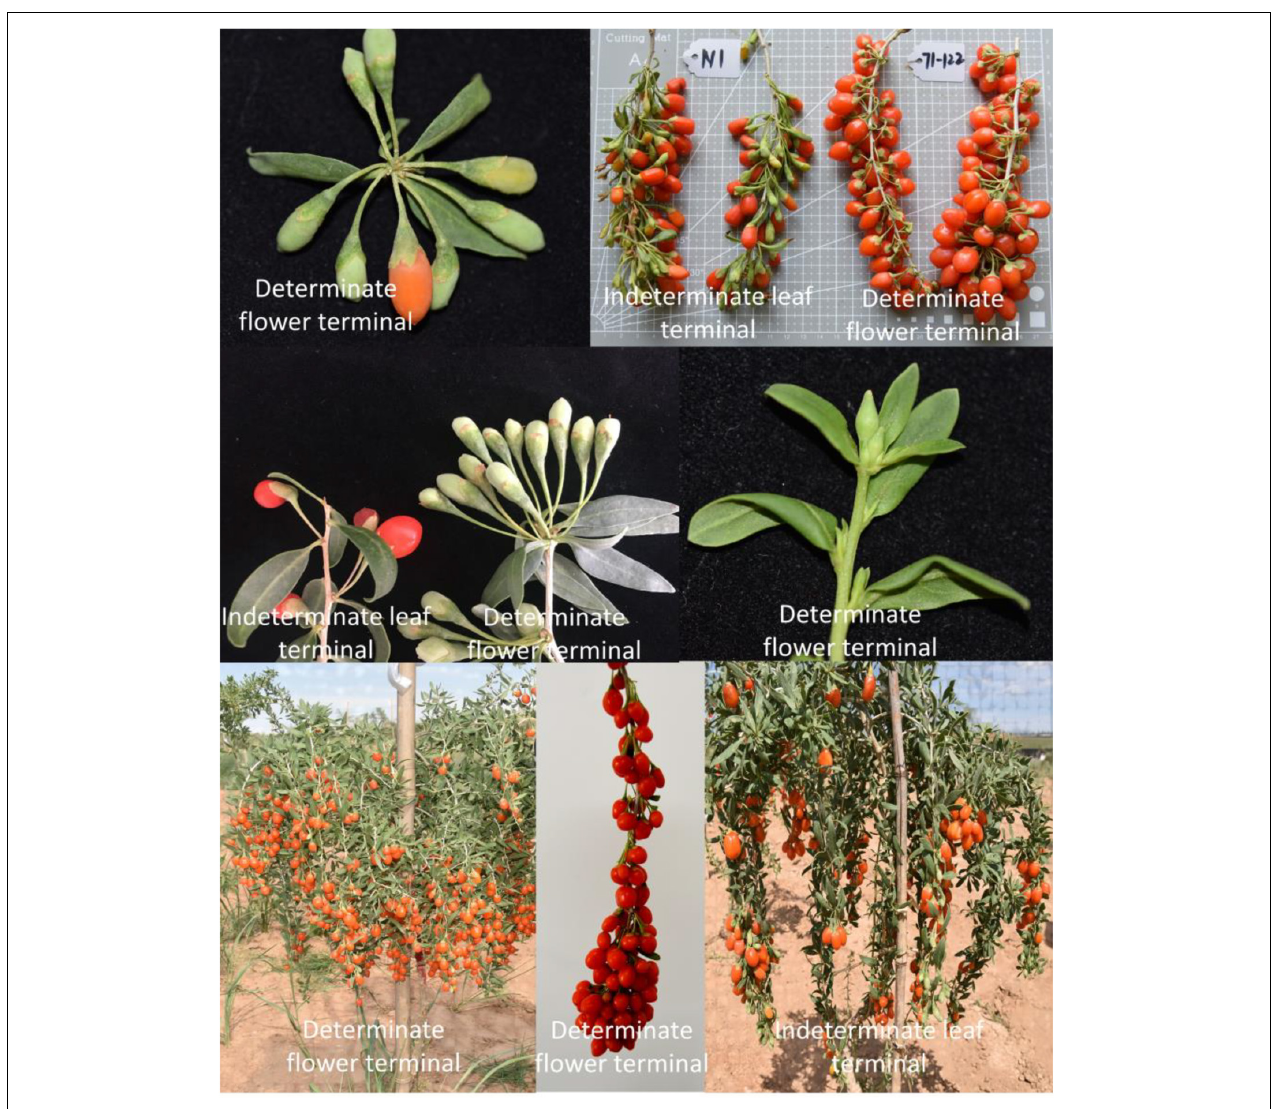
FIGURE 5 | Comparison of cultivars with indeterminate leaf terminal and determinate flower